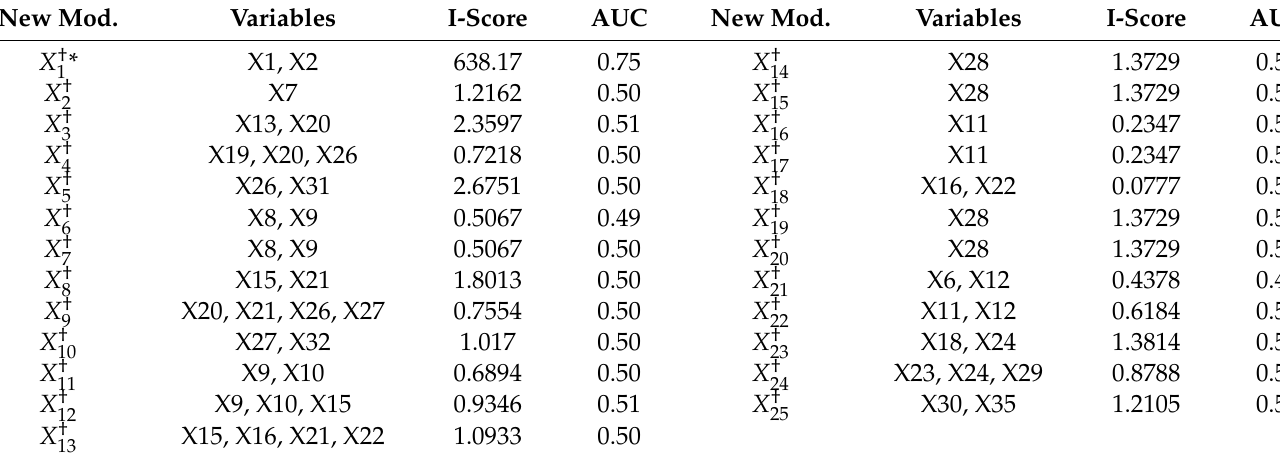
Table 3. Interaction-based convolutional layer. Foran artificial data set with 6 2 = 36 variables and a window size of 2 pass the window from the top left corner down to the bottom right corner. For each particular location, we have 4 variables to run the BDA. Before each observation had 36 features that could be sized 6 25 new features that have the shape of 5 extremely influential variable module(s). For each variable module, we also present the AUC value (see Section 4.4 for a detailed discussion of AUC values) assuming a classifier is built using this variable module alone. New